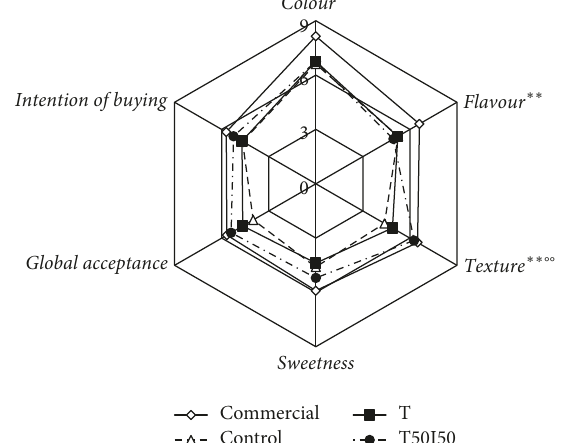
Figure 4: Results of the sensory analysis of watermelon jelly as a function of the formulation. Considering all jelly: ∗∗ 𝑝 value < 0.01 and without the commercial jelly: ∘∘ 𝑝 value <